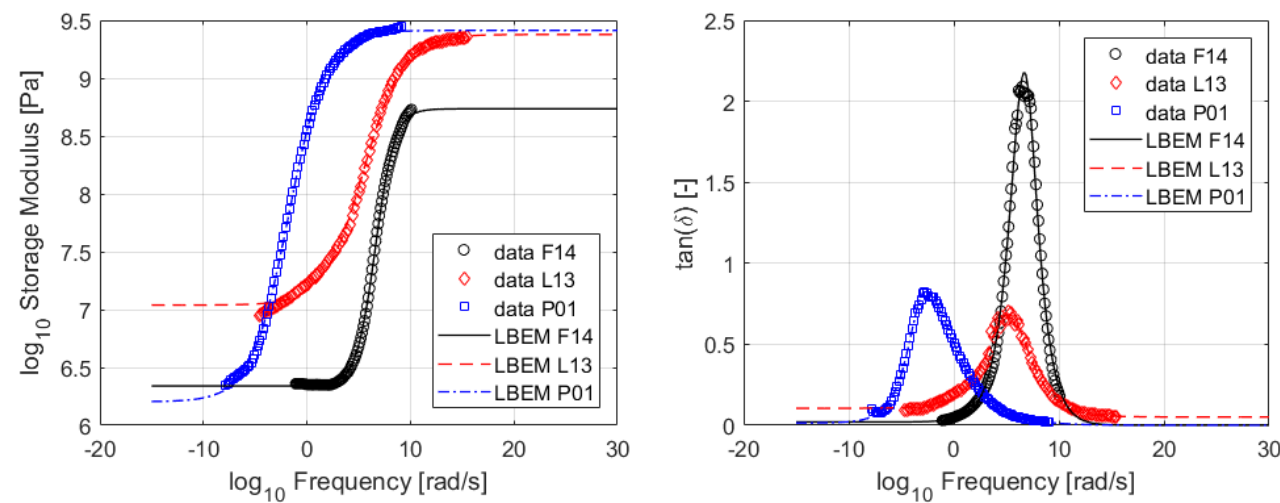
Figure 7. Storage moduli ( left chart ) and loss tangents ( right chart ) for three rubber compounds. Experimental data (markers) vs. LBEM model (lines).